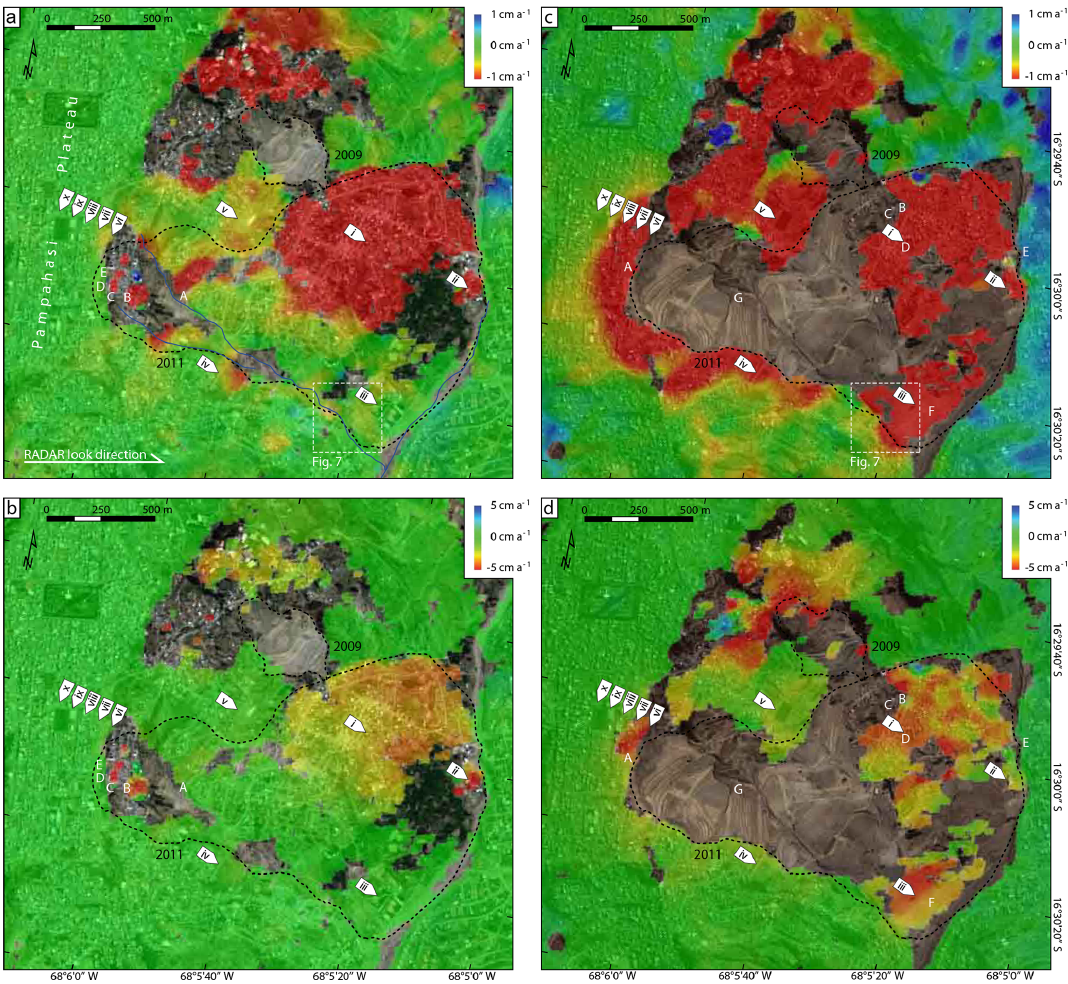
Figure 8. InSAR-measured line-of-sight ground displacements in the Pampahasi area. Average linear deformation rates during (a, b) the 30-month period before and (c, d) the 10-month period after the Pampahasi landslide. Compressed ( − 1 to 1cma − 1 ; a and c ) and expanded ( − 5 to 5cma − 1 ; b and d ) displacement scales emphasize, respectively, the spatial limits and spatial variability of slope activity. Dashed lines are the limits of landslides that occurred in 2009 and 2011 during the period of radar scene acquisition. Roman numerals show locations of displacement histories in Fig. 9. Letters show locations of photos taken, respectively, before (Fig. 5) and after (Fig. 6) the 2011 landslide. Base images are from GoogleEarth ( a, b 4 January 2011 and c, d 25 July